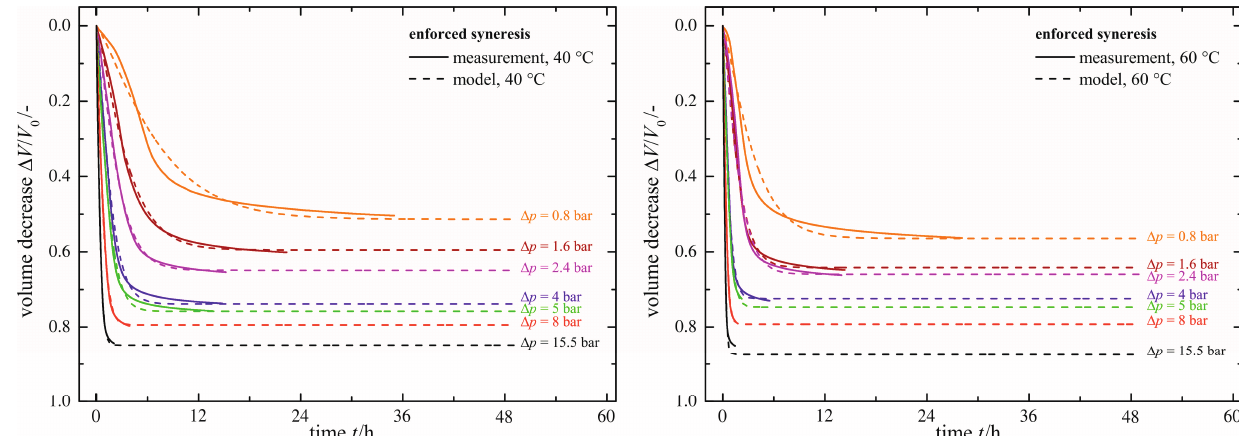
Figure 8. Enforced syneresis for ϑ = 40 °C and ϑ = 60